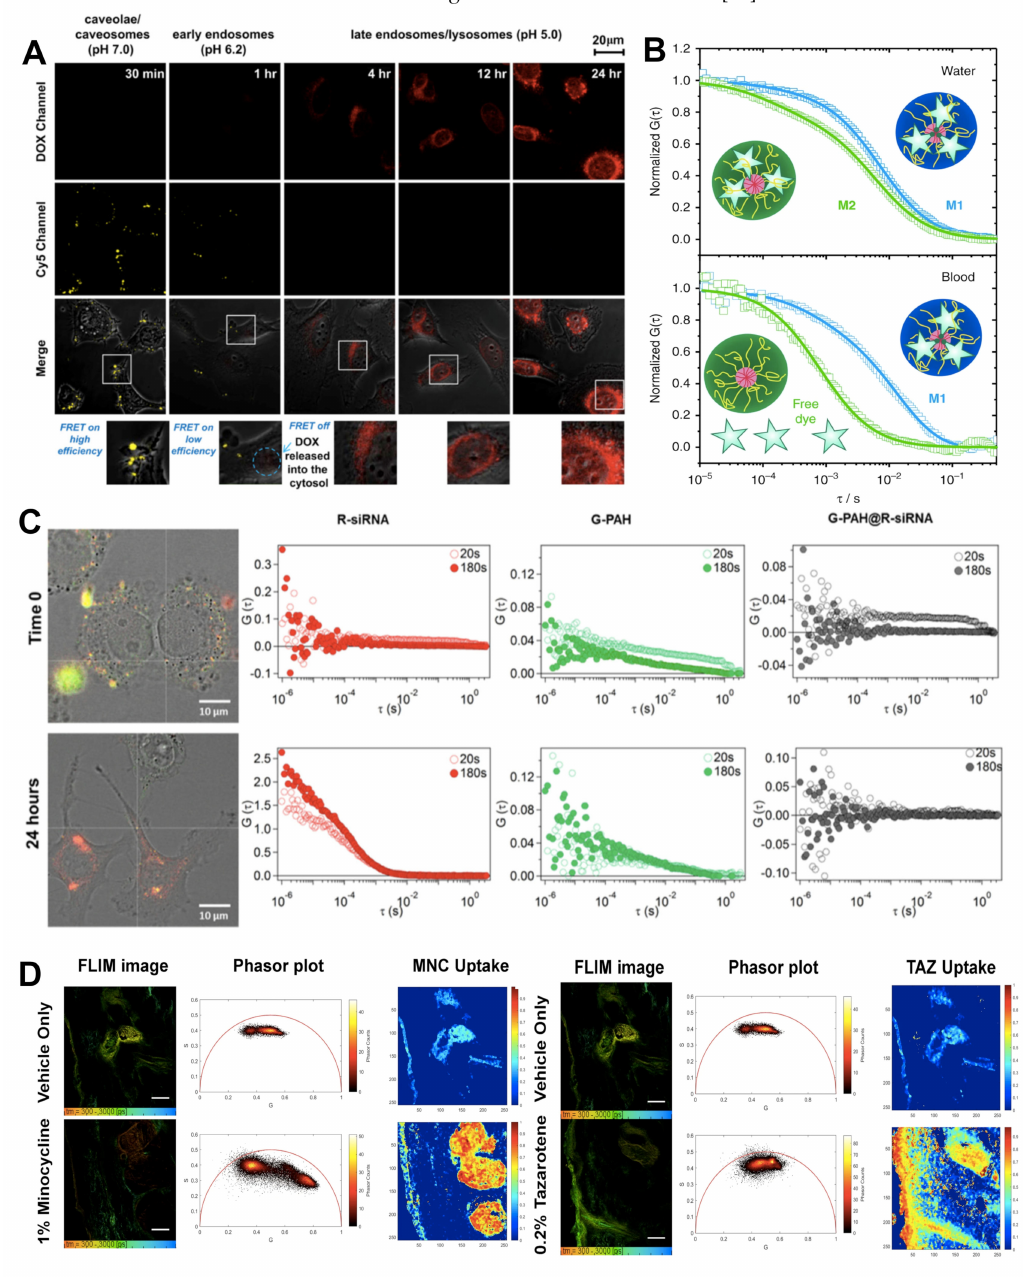
Figure 2. ( A ) Dual-emission fluorescence images of HT1080 cells; cells were incubated with DOX-loaded Cy5–NPCS nanoparticles for distinct durations and fluorescence images were then taken by CLSM in optical windows between 560 and 600 nm (DOX imaging channel) and 660 and 700 nm (Cy5 imaging channel) when irradiating NC suspensions at 488 nm. Reproduced with permission from [58]. Copyright 2011 Elsevier. ( B ) NIR-FCS studies of the loading stability of core-crosslinked micelle nanocarriers in blood. Normalized autocorrelation curves (symbols) and the corresponding fits (lines) are shown for core-crosslinked micelles that were either covalently (M1, blue colour) or noncovalently (M2, green colour) loaded with IRDye ® 800CW. Measurements in water ( upper panel ). The dye is mainly loaded to the core-crosslinked micelles and only a small fraction of free dye was detected for both systems. Measurements in the blood flow (velocity of 50 µ L h − 1 ) upon incubation with blood for 30 h (at 4 ◦ C) ( lower panel ). The dye is fully released from M2, but still loaded to M1. Reproduced with permission from [75]. Copyright 2018 Springer Nature. ( C ) Representative cross-correlation experiment in live cells. A549 cells were imaged in transmission mode and cross-correlation was measured at specific locations inside the cell (white cross). Cells were incubated with the nanoparticles (N/P = 2) in RPMI complete medium. The cells were imaged just after incubation with the nanoparticles (Time 0), and after incubation for a further 24 h in